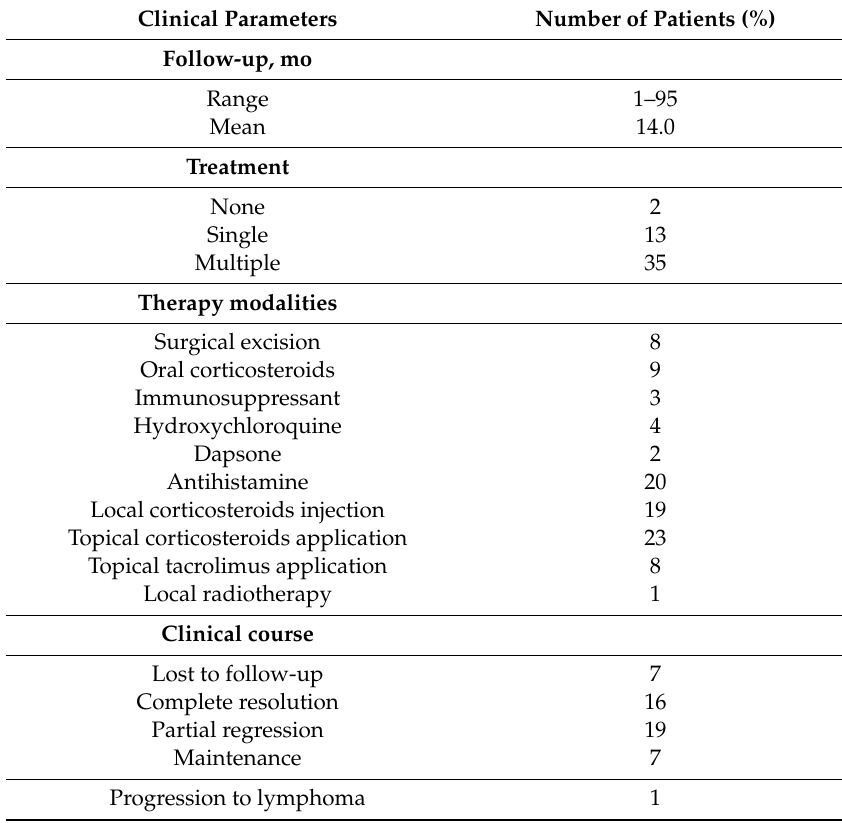
Table 4. Treatment modalities and clinical courses of cutaneous lymphoid